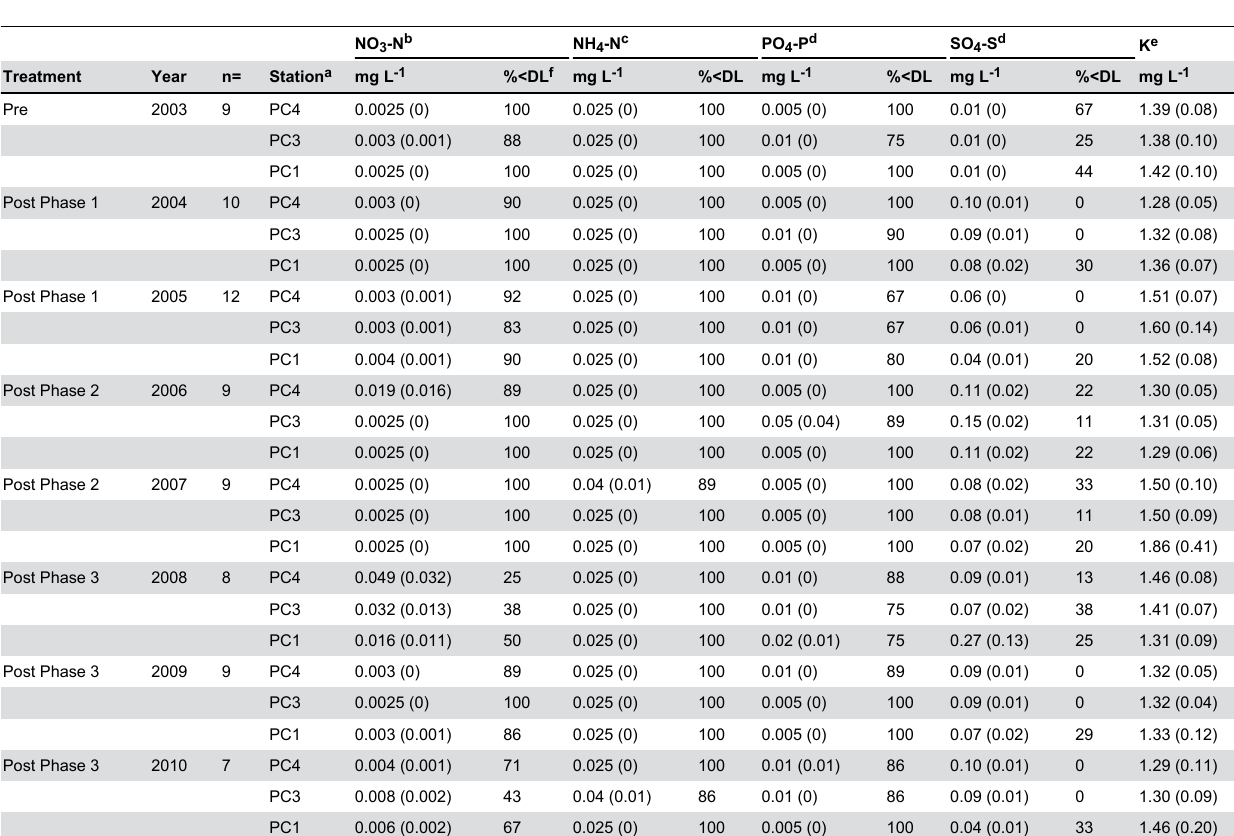
Table 3. Mean annual nutrient concentrations measured at Pine